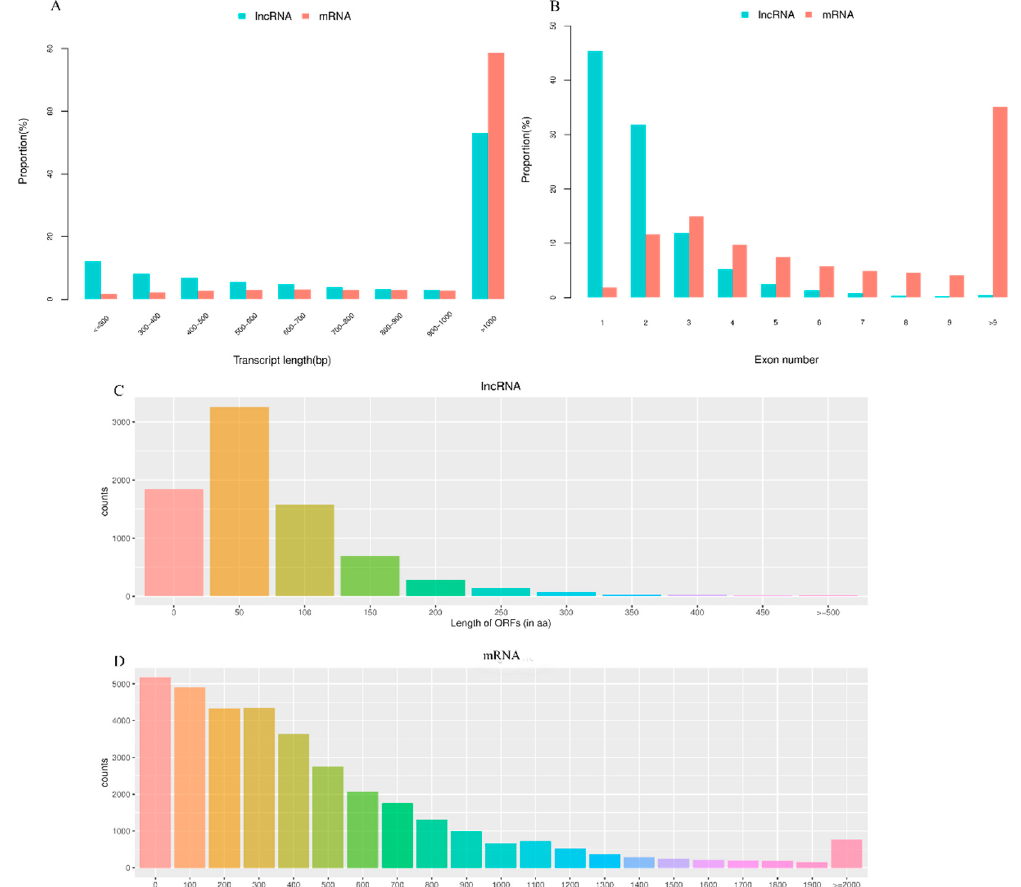
Figure 1. Genomic features of lncRNAs in the testes of pigeon. ( A ) The transcript length distribution of lncRNAs and mRNAs. ( B ) The exon number distribution of lncRNAs and mRNAs. ( C ) The ORFs length distribution of lncRNAs. ( D ) The ORFs length distribution of mRNAs.